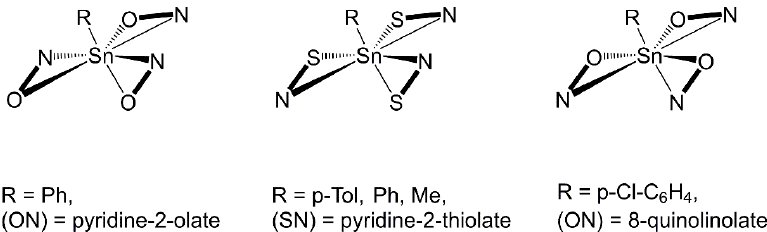
Figure 3. Generic illustration of the conformational difference between PhSn(pyO) 3 , related pyridine-2-thiolates RSn(pyS) 3 [28,29] and 8-quinolinolate (4-Cl-C 6 H 4 )Sn(ox) 3 [30]. The motifs “N–O” and “N–S” serve as abbreviations of the different bidentate (N,O)- and (N,S)-donor